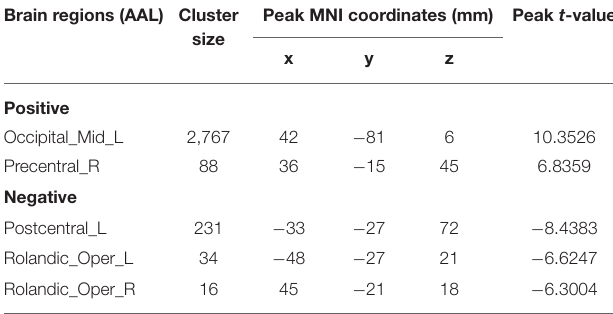
TABLE 3 | Brain regions with significant differences based on a paired-sample t -test of SO and SS (voxel-level, FDR-corrected p < 0.001, cluster size > 10